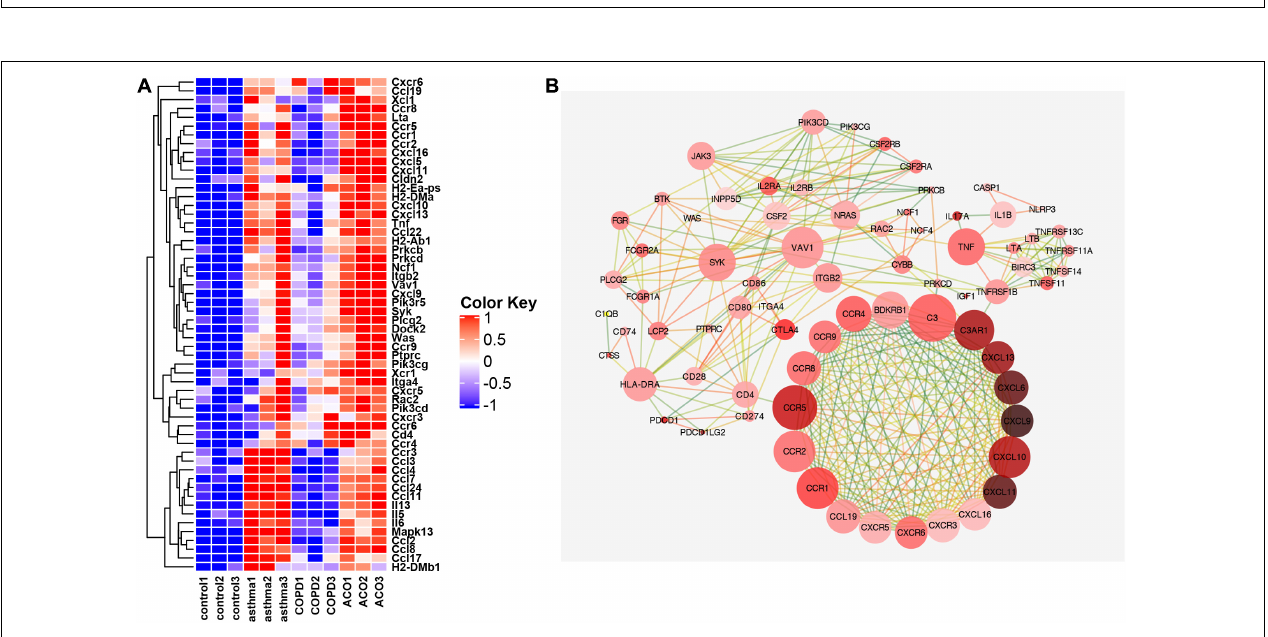
FIGURE 6 | Key genes of inflammation pathway. (A) the FPKM expression levels of genes appearing in more than two pathways in GSEA analysis are shown. (B) protein interaction network diagram of genes with correlation coefficient > 0.9. The color of dot display (light red to dark red indicate that the expression multiple has increased from 0.49 to 5.7 times) indicated the multiple difference between the ACO and control group [log2 (FPKM) value]. The line represented the correlation coefficient between proteins calculated based on a string (correlation coefficient 0.9 is dark green, one is orange-red, and the correlation between 0.9 and 1 is excessive from green to orange; the closer correlation is to 1, the more vital the protein interaction is).